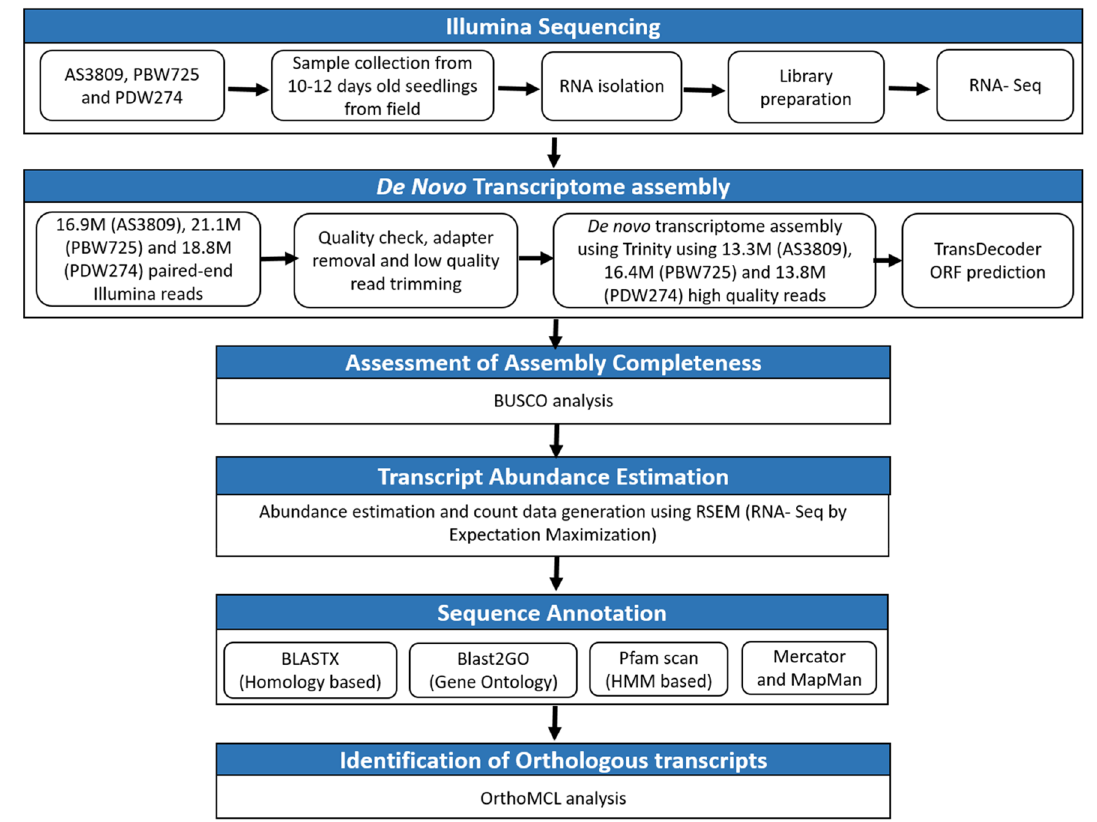
Figure 7. Schematic representation of de novo transcriptome reconstruction and analysis pipeline used to generate whole transcriptome assemblies for Aegilops speltoides acc. pau3809, Triticum aestivum cv. PBW725 and Triticum durum cv.